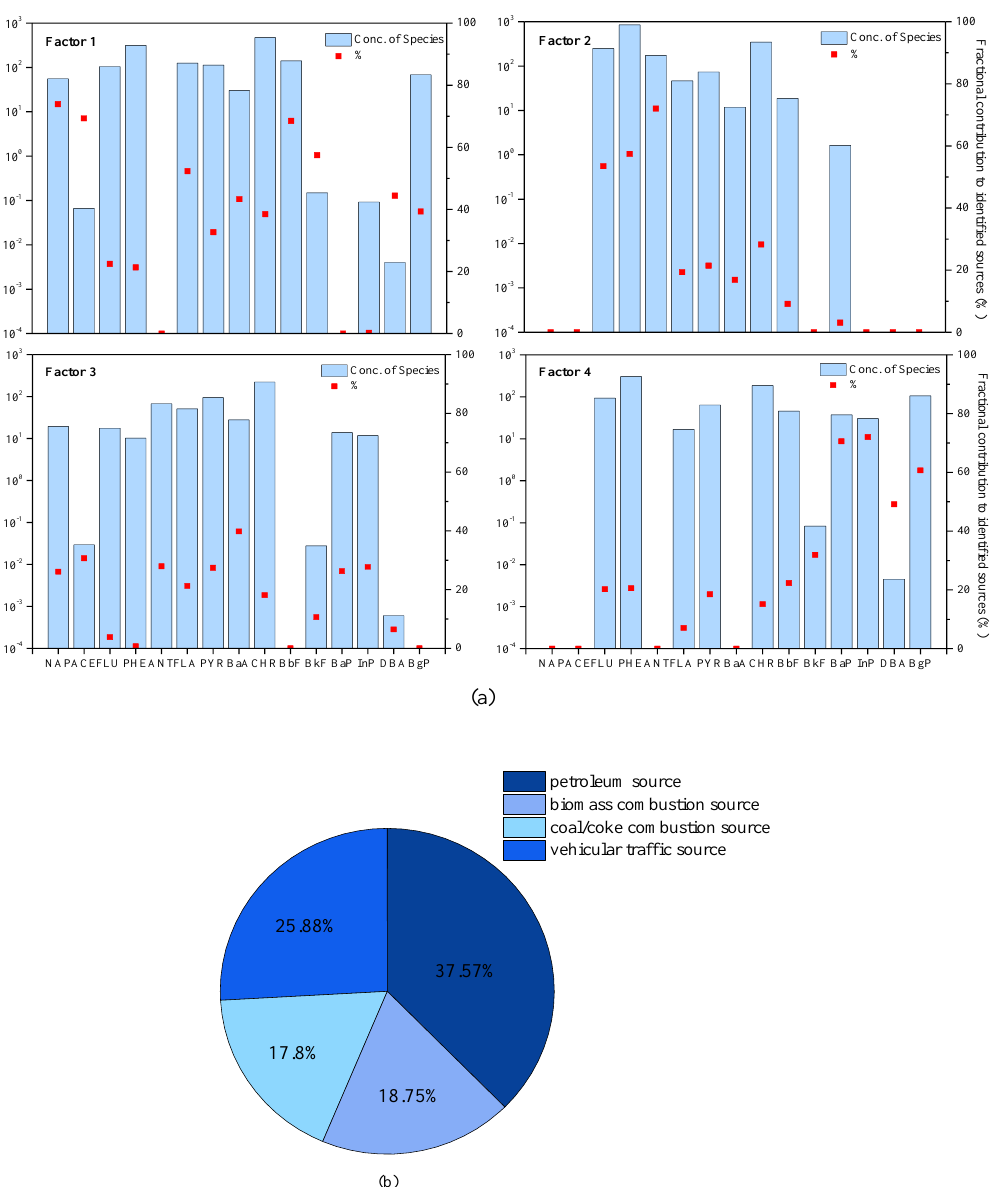
Figure 5. Results of the Positive Matrix Factorization (PMF) model: ( a ) Source profiles of each PMF factor and ( b ) percentage source contributions of each factor to total PAHs. All the PAHs abbreviations used are explained in Supplementary Table S1.